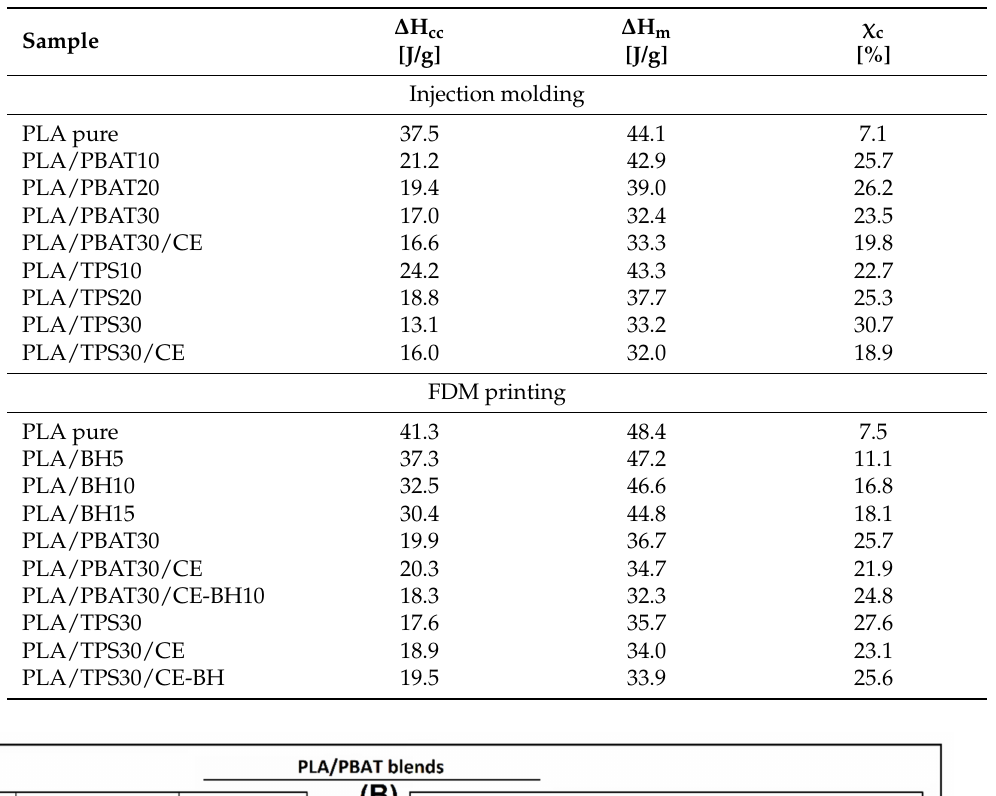
Table 2. The results of the DSC thermograms analysis, cold crystallization and melting enthalpy, and PLA crystalline phase content.